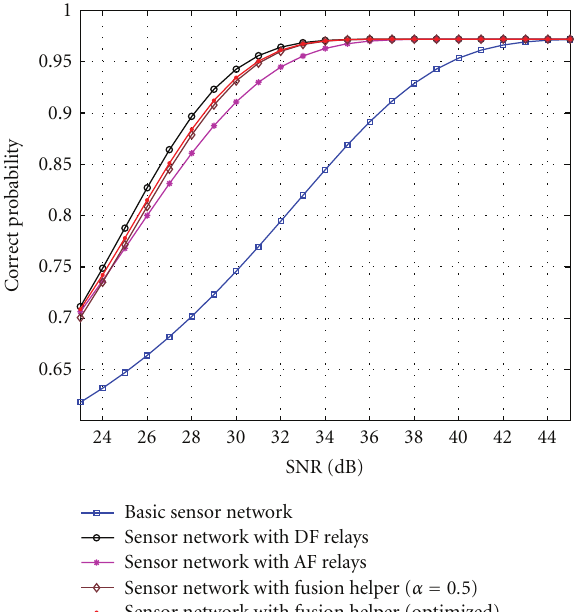
Figure 2: Theoretical correct probability of the overall decision in di ff erent sensor networks with Gaussian channels ( A = 0 . 9, β = 3 . 5, d =